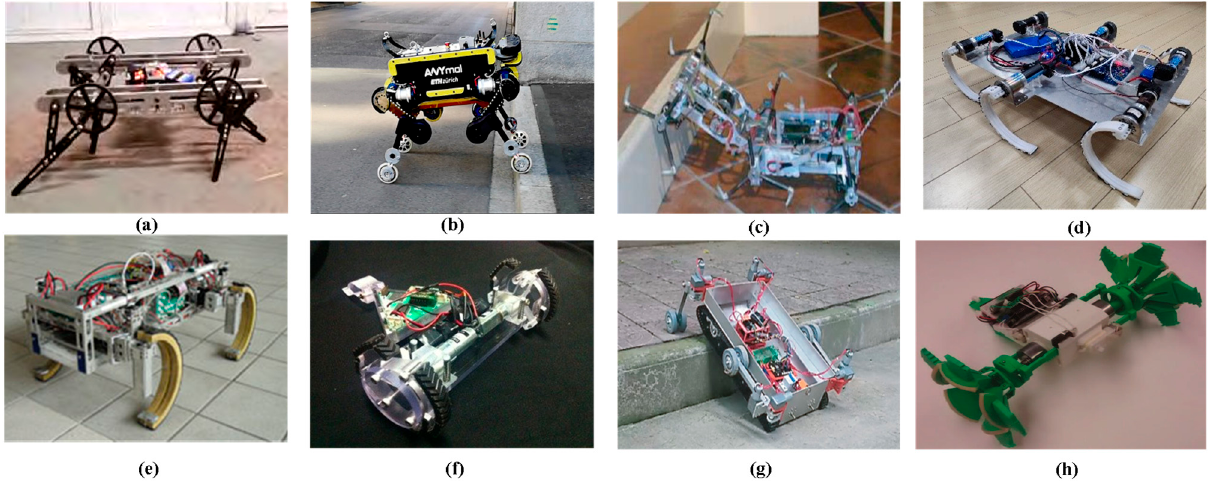
Figure 1. ( a ) Deformable wheel-legged robot with the Chebyshev mechanism [8]; ( b ) ANYMAL ro- bot [9,10]; ( c ) Whegs robot [12]; ( d ) wheel-legged hexapod robot [13]; ( e ) Quattroped: a leg–wheel hybrid mobile platform [14]; ( f ) wheel transformer robot [15,16]; ( g ) wheel–track–leg composite bi- onic robot [17]; ( h ) transformable wheel robot with a passive leg